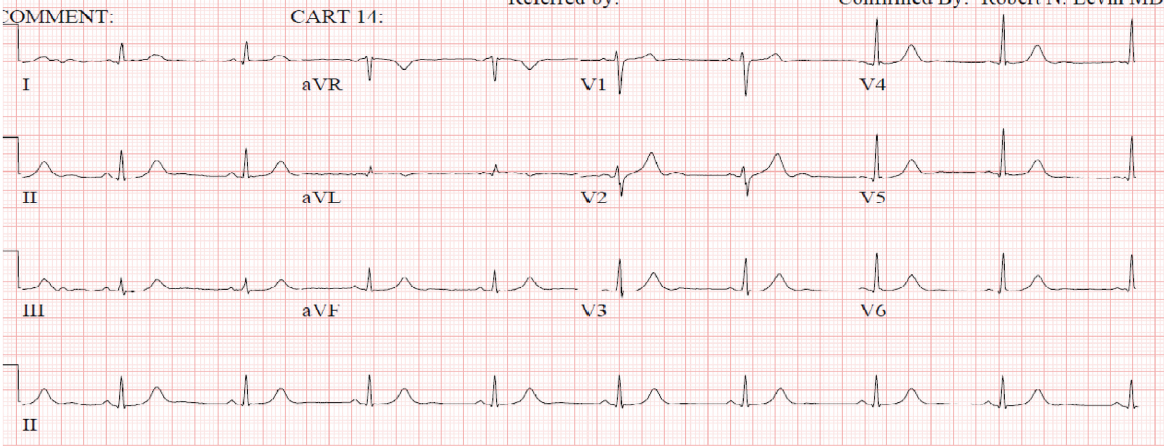
Figure 3: ECG from the same patient in normal sinus rhythm. T wave inversions not evident in V1 and